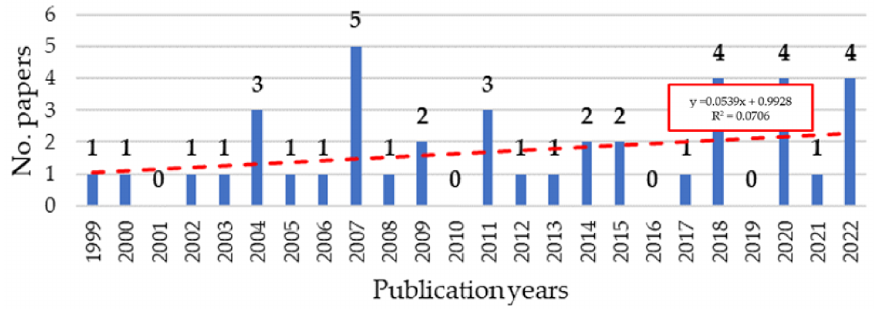
Figure 3. Distribution of papers by